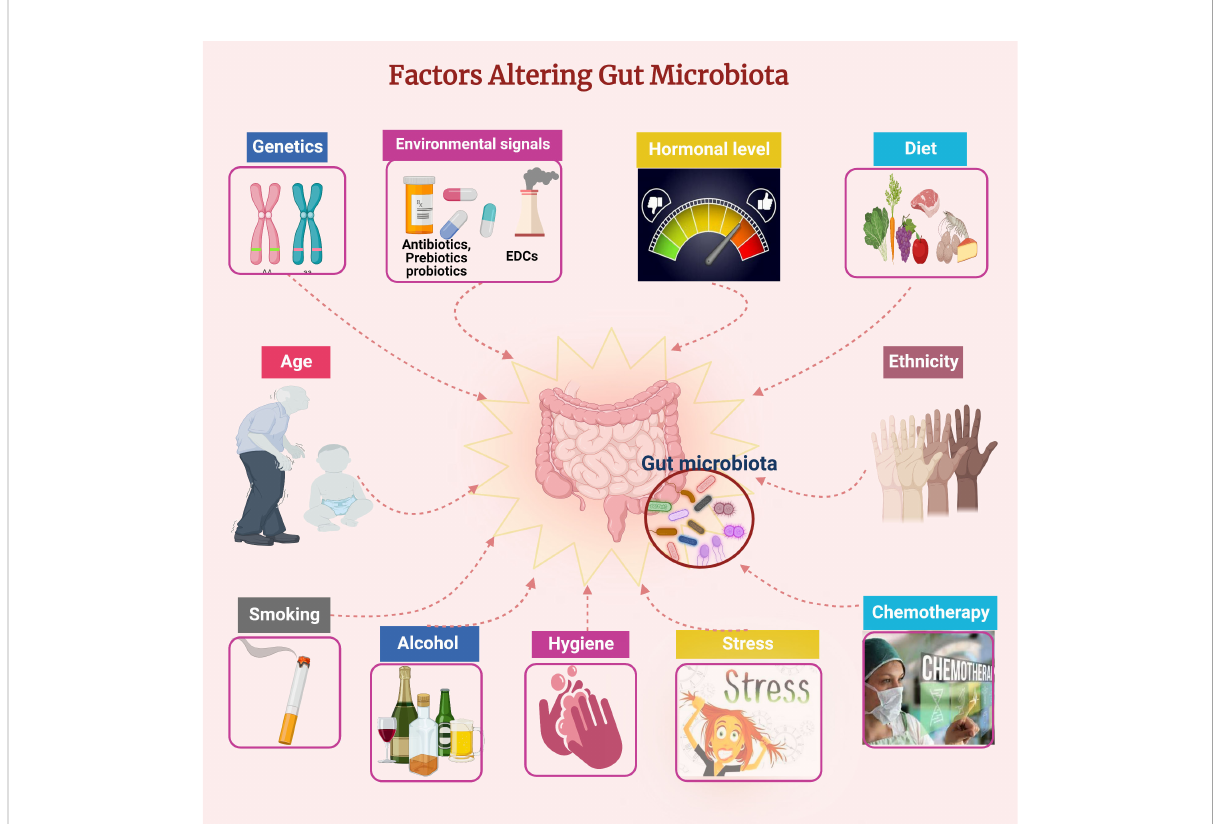
FIGURE 1 Factors affecting the gut microbiota composition. Figure created using